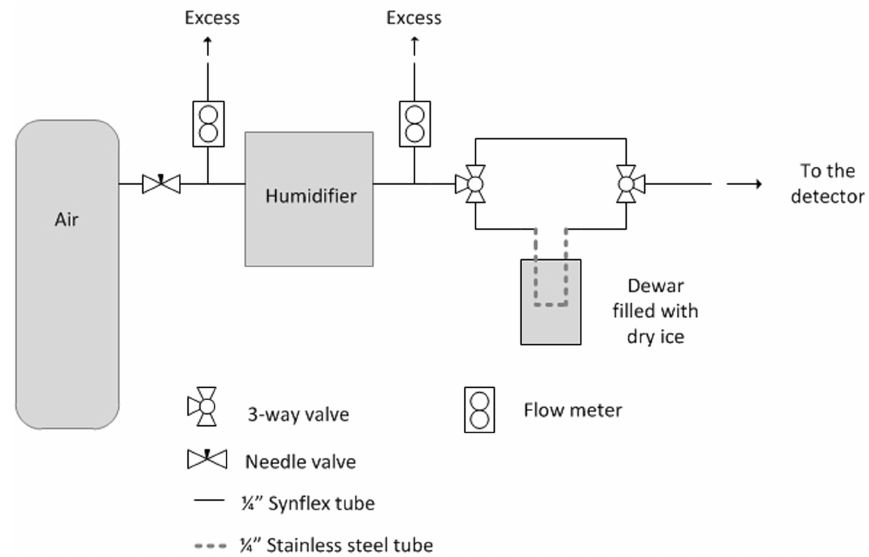
Fig. 4. A schematic of the experimental set-up used to determine how water vapour influences CO 2 and CH 4 measurements. The humidifier used was a Li-610 dew-point generator (Li-610, Li-Cor Inc.,